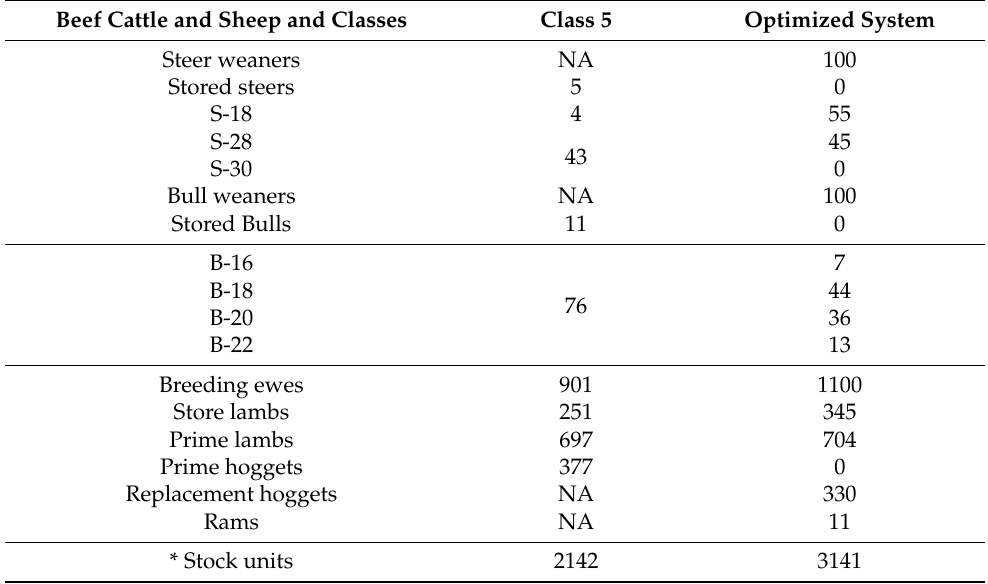
Table 4. The number of weaner steers and bulls, stored (sold to other farmers for finishing) and finished steers (S-18, S-28, and S-30) and bulls (B-16, B-18, B-20, and B-22) (sold for meat processing), breeding ewes and rams, prime lambs (sold for meat processing) and store lambs (sold to other farmers for finishing), and prime hogget (between 4 to 16 months of age, sold for meat processing plant) and replacement hoggets (between 4 to 16 months of age, mated at 8 months of age) as well as their equivalent stock units in an average Class 5 farm and optimized